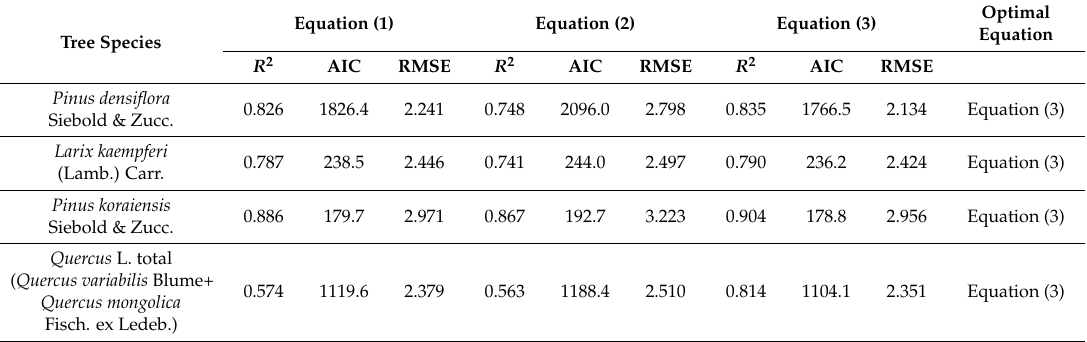
Table 2. Comparison of coefficient of determination ( R 2 ), Akaike’s information criterion (AIC) and root mean square error (RMSE) for the models corresponding to each tree species.